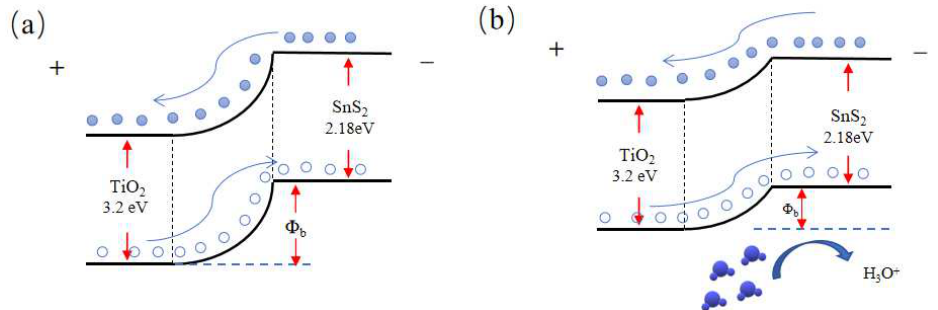
Figure 7. The energy band variations of the TiO 2 -SnS 2 heterojunction after adsorbing water molecules at ( a ) without water and ( b ) with water.